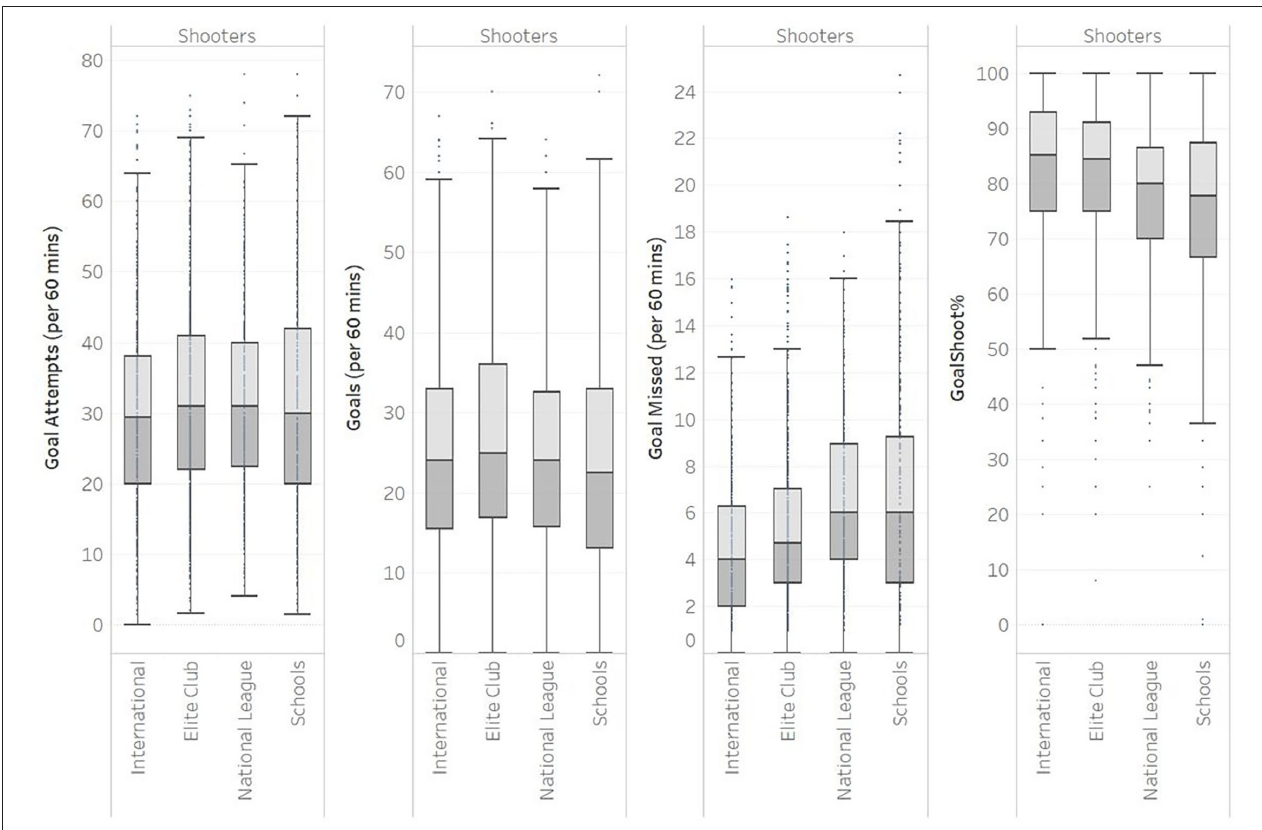
FIGURE 3 | Box and whisker plots of various level of netballs normative data for goal scoring